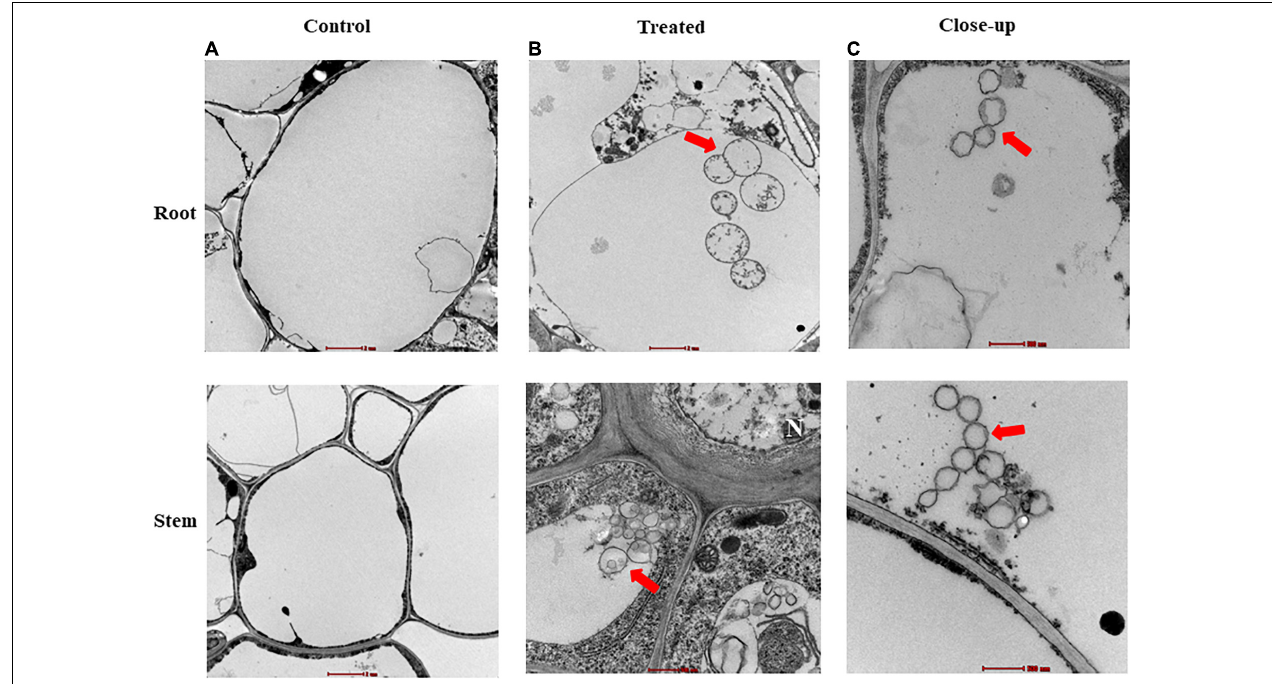
FIGURE 4 | Inter- and intra-cellular colonization of mangrove tissues by the endophytic isolate #24. Transmission electron micrograph of ultra-thin sections of a 6-week-old gray mangrove (A) non-inoculated (control; 6,000 × ) and (B) inoculated (treated; 6,000 × ) root (top) and stem (bottom) tissues with Streptomyces mutabilis UAE1. (C) A close-up of spiral chain of spores of S. mutabilis UAE1 within the root (top) and stem (bottom) tissues (20,500 × ). In (A–C) , all sections were stained with uranyl acetate and lead citrate showing the distribution of spiral chain of spores (red arrows). Isolate #24 represents the endophytic PA-producing Streptomyces mutabilis UAE1. PA, polyamine. Bars: (A,B -top ) 2 µ m; and (B -bottom, C) 500 nm. N,